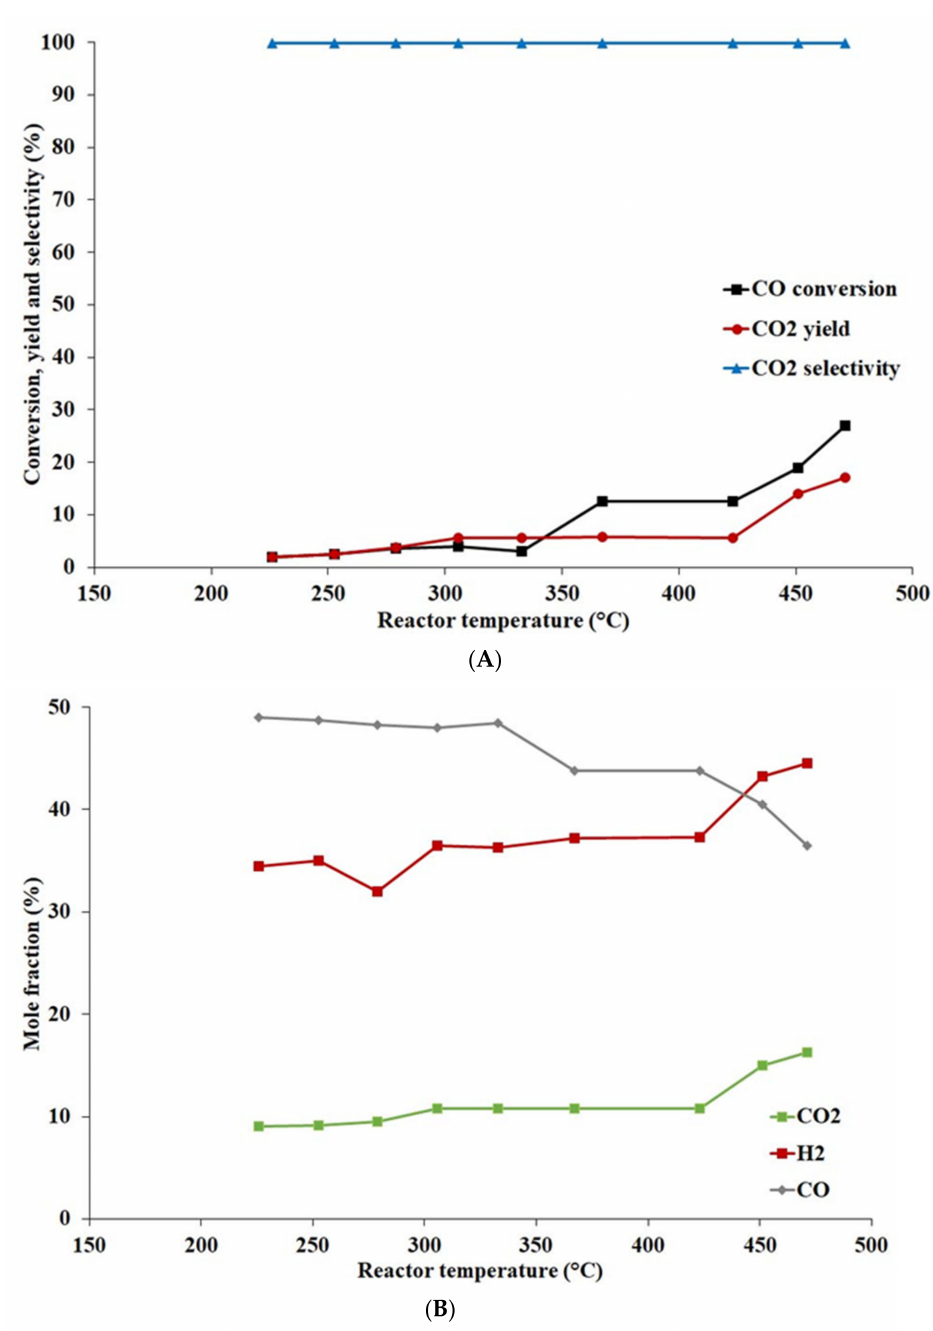
Figure 22. Catalytic tests with feed gas mixture 3 (50 mole% CO, 34 mole% H 2 , 8 mole% CO 2 , 0.4 mole% H 2 S, balance N 2 ) at pressure 0.5 MPa over a Co-based catalyst (9.6 wt%): ( A )—CO conversion, CO 2 yield, and CO 2 selectivity; ( B )—produced gas